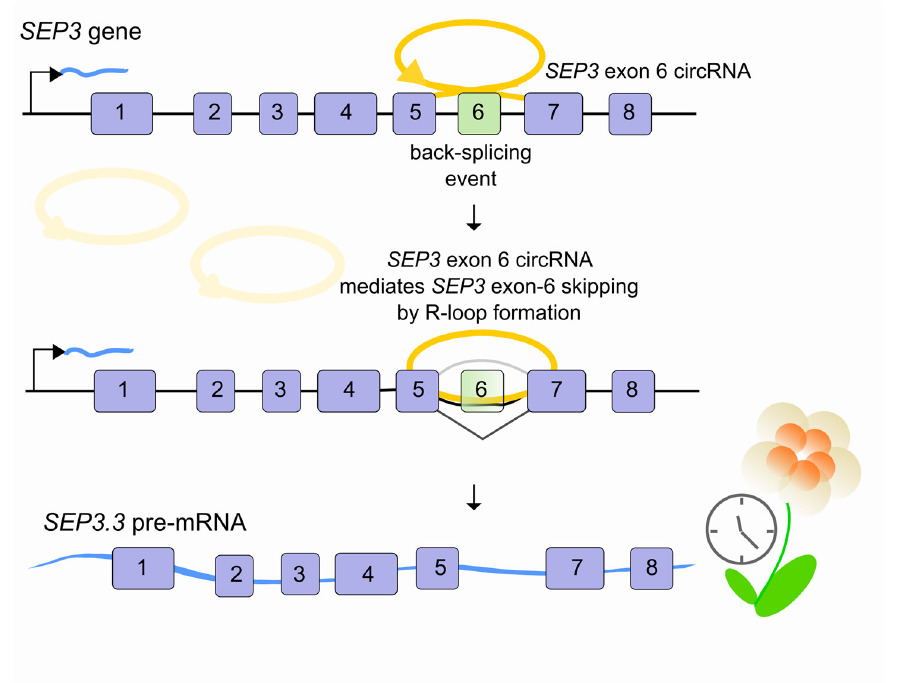
Figure 3. LncRNAs regulate pre-mRNA splicing through an RNA-DNA interaction. In Arabidopsis thaliana , when the SEP3 gene is transcribed, exon 6 can be back-spliced into a circular RNA ( SEP3 exon 6 circRNA, yellow) which interacts directly with its parental genomic locus. By forming RNA–DNA hybrids (R-loops), SEP3 exon 6 circRNA favors exon-6 skipping of its linear cognate and promotes the SEP3.3 mRNA (light blue) isoform accumulation which in turn affects flowering time.